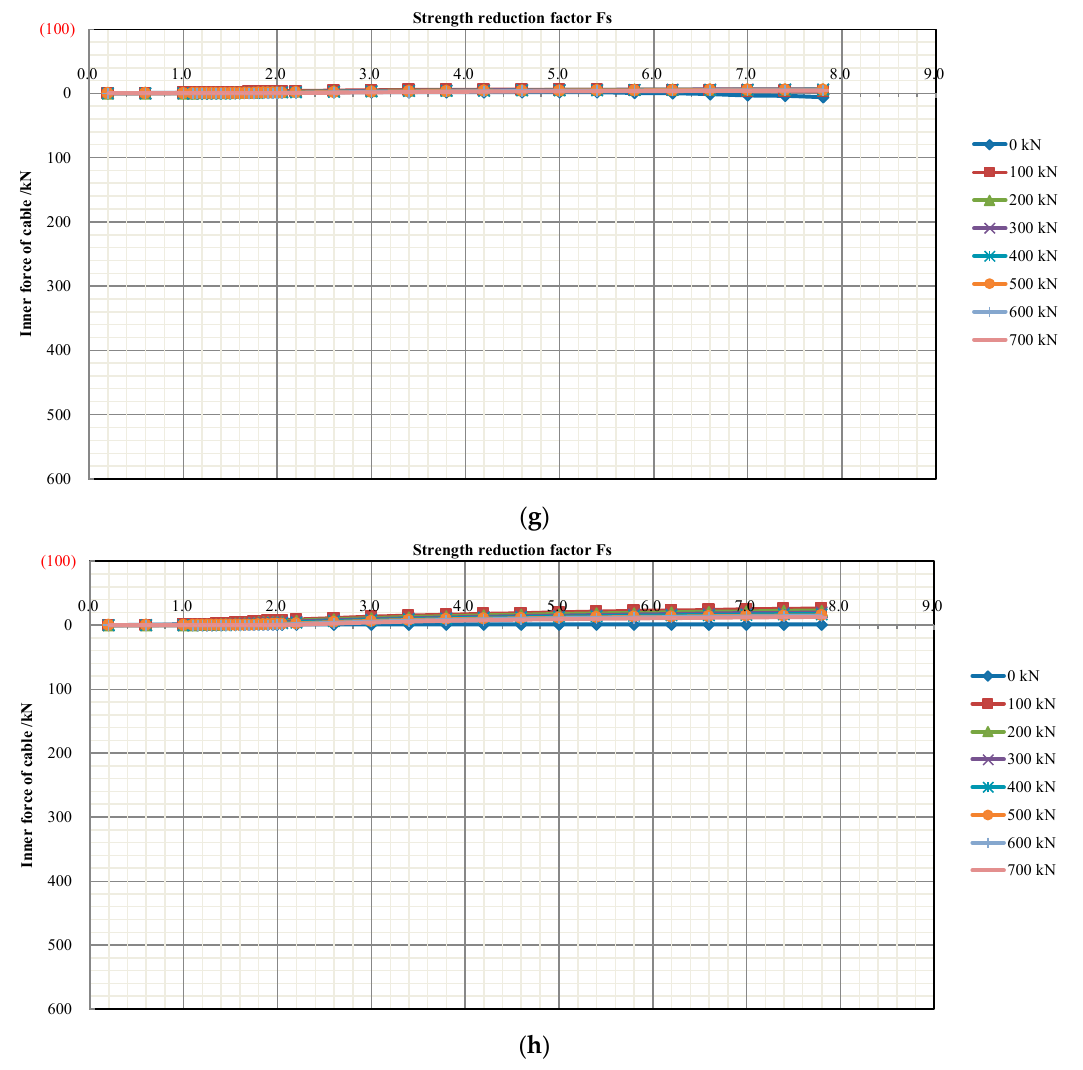
Figure 9. Variation of force with different strength reduction factors in certain cables. ( a ) Cable 1; ( b ) Cable 3; ( c ) Cable 5; ( d ) Cable 8; ( e ) Cable 10; ( f ) Cable 12; ( g ) Cable 13; ( h ) Cble 15.